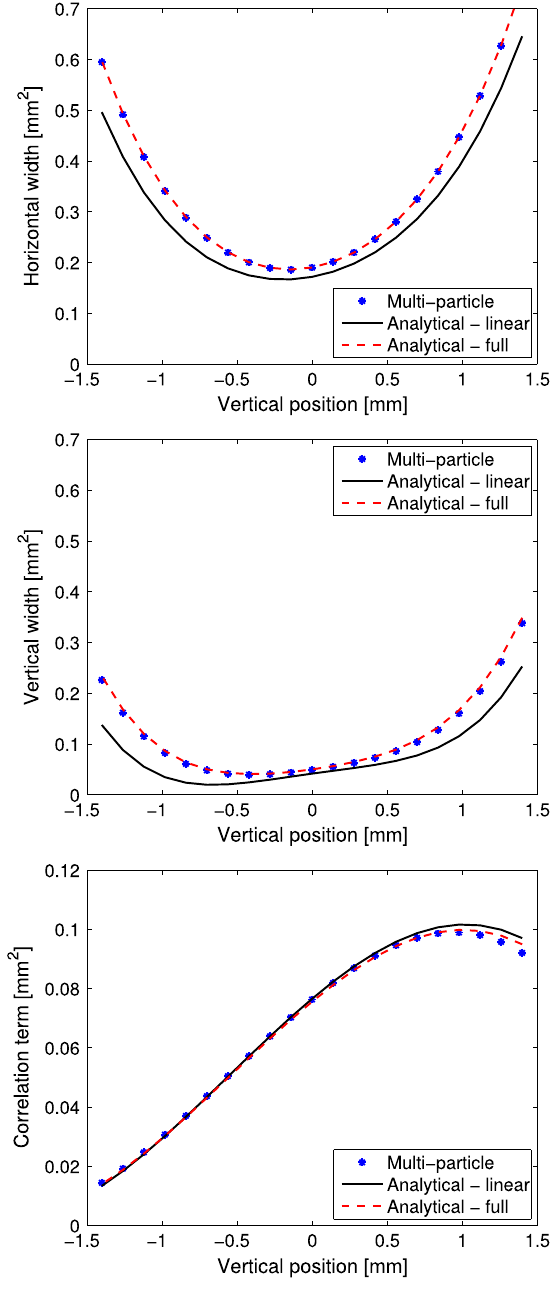
FIG. 4. Simulation of a beam with correlations. Plots show the beam widths σ 2 x (top), σ 2 y (middle) and correlationterm σ xy (bottom) on the screen for different vertical positions inside the octupole field. Also plotted are the corresponding linear expressions (10) – (12) and the full analytical expressions (A11) – (A13). By per- forming fits we can determine the beam matrix just upstream of the octupole. However, using the linear equations will introduce